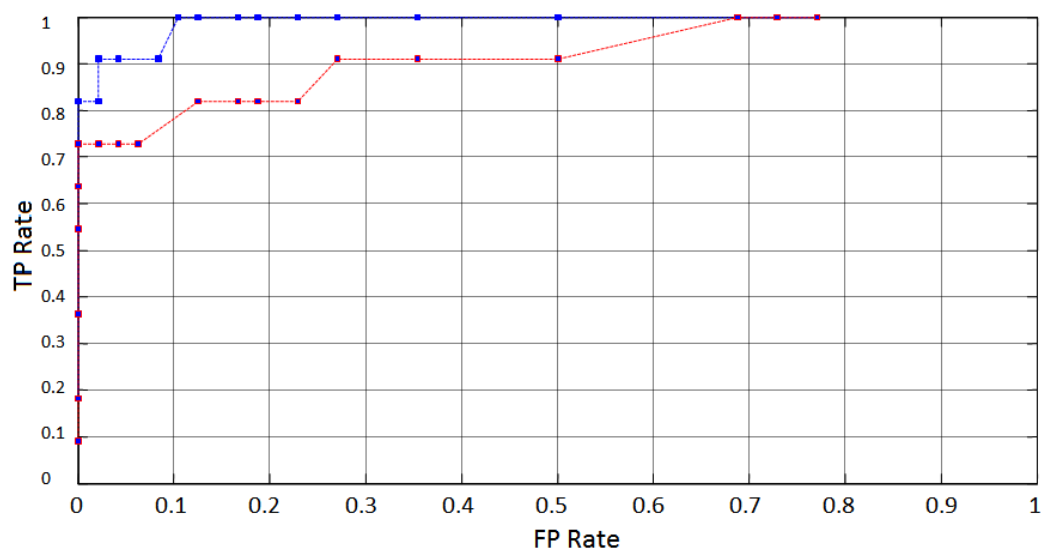
Figure 19. Average ROC curves obtained for EMD decomposition from AF4 (blue) and for Wavelet decomposition (red) from the same